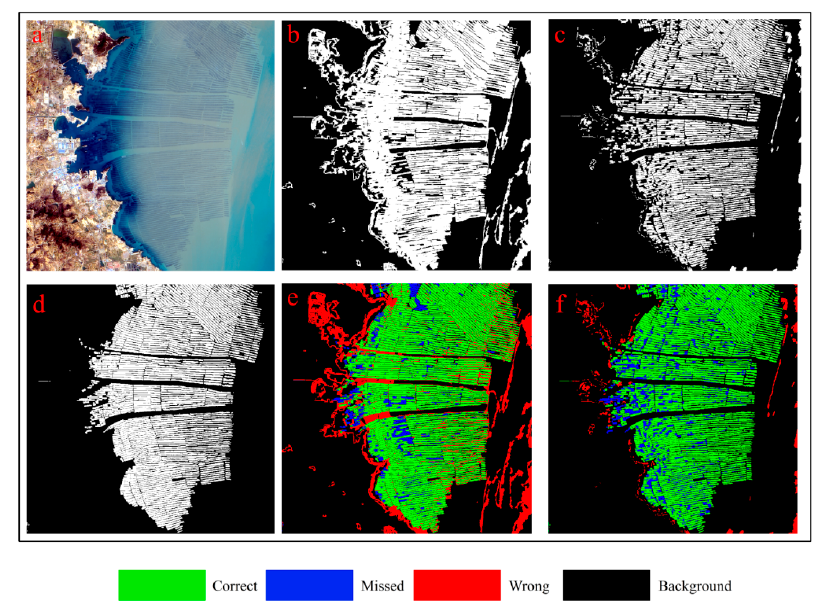
Figure 6. Results of two experimental methods for study area 2: ( a ) Initial image; ( b ) OBVS-NDVI extraction result; ( c ) Proposed extraction result; ( d ) Human interpretation result; ( e ) Overlap of OBVS-NDVI result with human interpretation result; ( f ) Overlap of proposed result with human interpretation result.